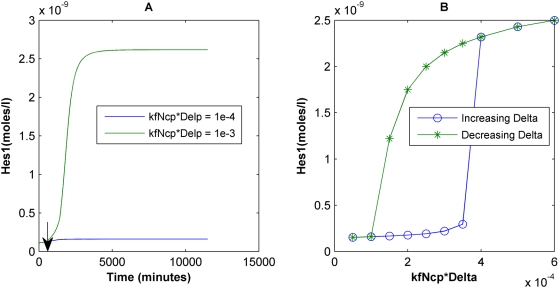
Bistability in Notch signaling.(A) Deterministic Hes1 trajectories as a function of time for two different strengths of Delta signals given as a product of the Delta concentration and the rate constant of formation of NICD upon Delta-Notch binding (kfNcp*Delp = kDelp). These deterministic simulations were initiated using steady state values of the system under no Delta signal and at t = 750 minutes (indicated by vertical arrow) the input Delta signal was applied. (B) Hysteresis in the Notch1-Hes1 network, where Hes1 concentration can attain two possible steady states for an intermediate range of Delta inputs. The point of switching depends on whether the Delta signal is increasing or decreasing.